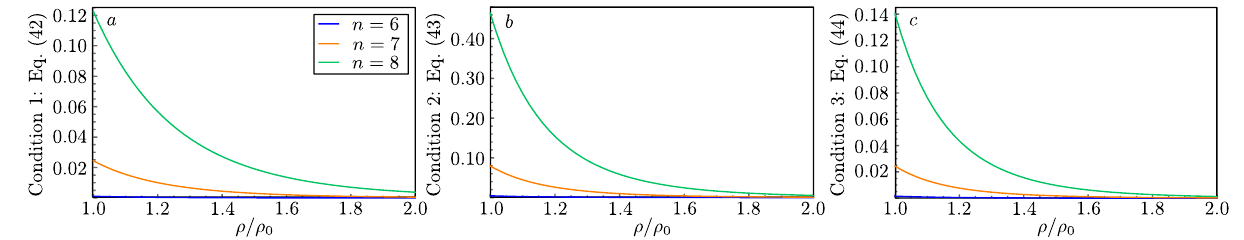
Figure 2. The value of near flow conditions for power-law blobs of n = 6 (blue), n = 7 (orange) and n = 8 (green). ( a ) Displays the result from condition Equation (37) (Equation (42)), ( b ) displays the result from condition Equation (38) (Equation (43)) and ( c ) displays the result from condition Equation (39) (Equation